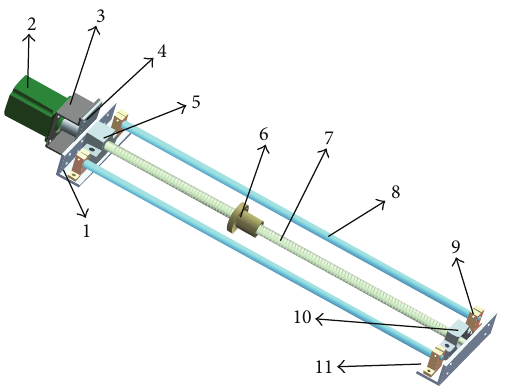
Figure 4: Work flow of grafting robot.